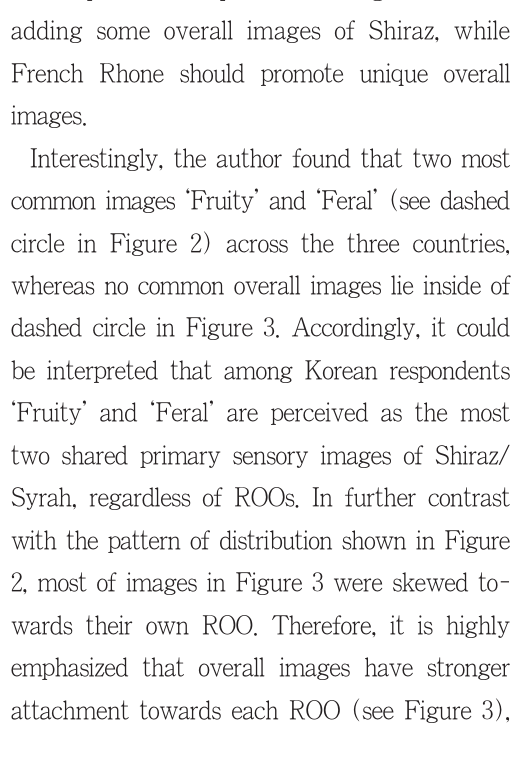
<Figure 2> Aroma Images Correspondence